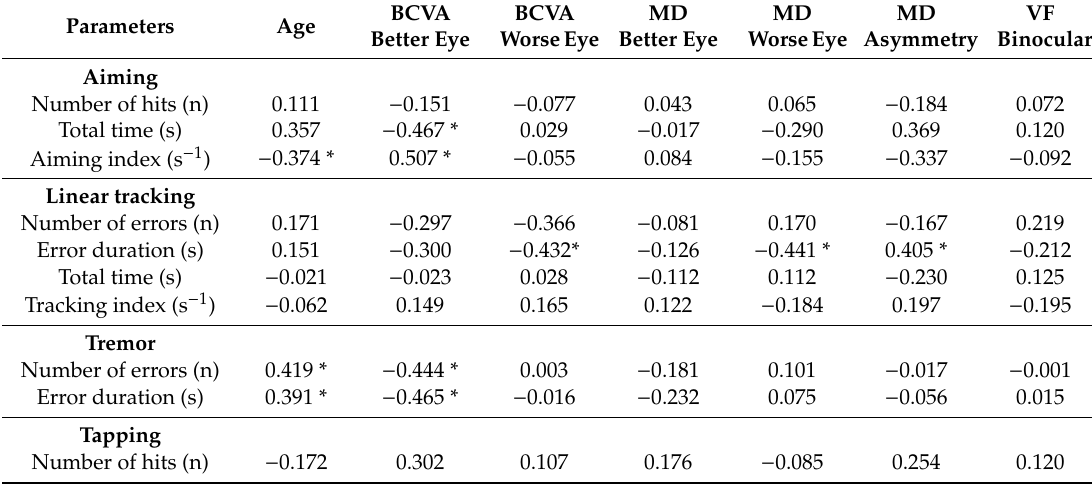
Table 3. Spearman’s correlation coe ffi cient for eye–hand coordination parameters, age, visual acuity, and VF defect severity (deviation scores for each eye, binocular VF score) in glaucoma